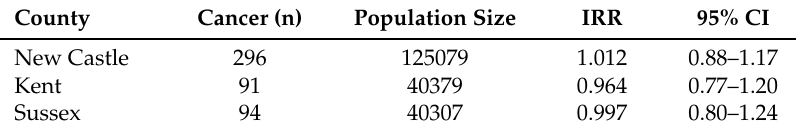
Table 3. Cummulative incidence risk ratio of pediatric cancer by county in DE, 2004–2014.